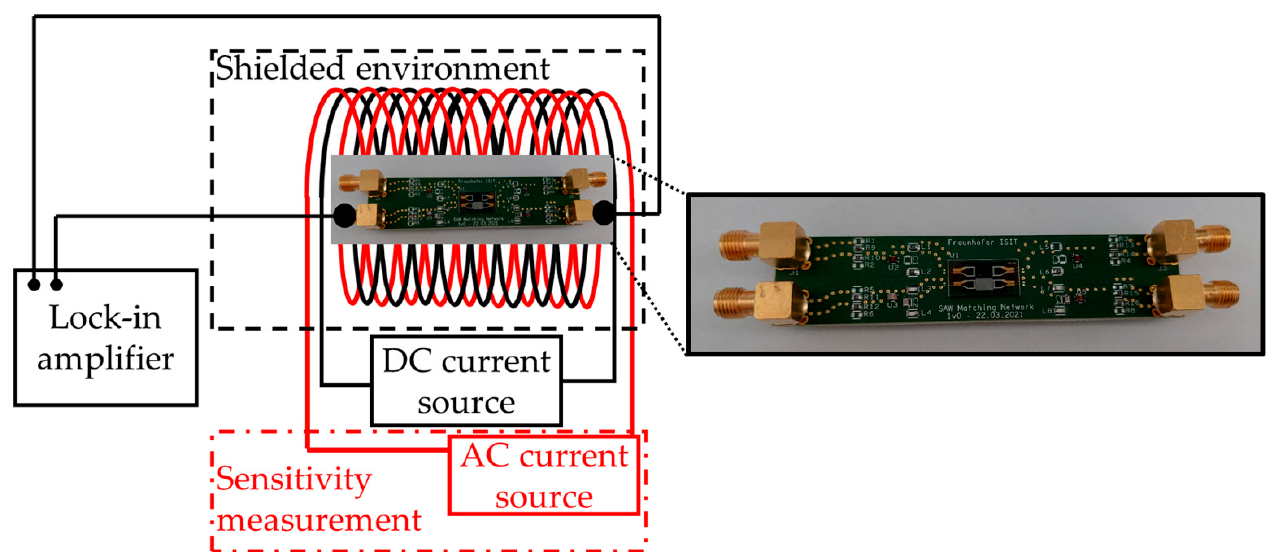
Figure 3. Sketch of the measurement setup. The SAW sensor is placed in a magnetically, electrically, and acoustically shielded measurement chamber inside of two solenoids. For the phase shift measurements, only a dc current source is used to apply a homogeneous magnetic field. A lock-in amplifier is used to apply the synchronous SAW frequency and measure the phase change. The sensitivity S is measured by applying an additional ac magnetic field using the second solenoid that is supplied with another current source using a test amplitude and frequency. The inset shows a zoom-in of the ready-to-use sensor with a balun attached to symmetrize the signal.